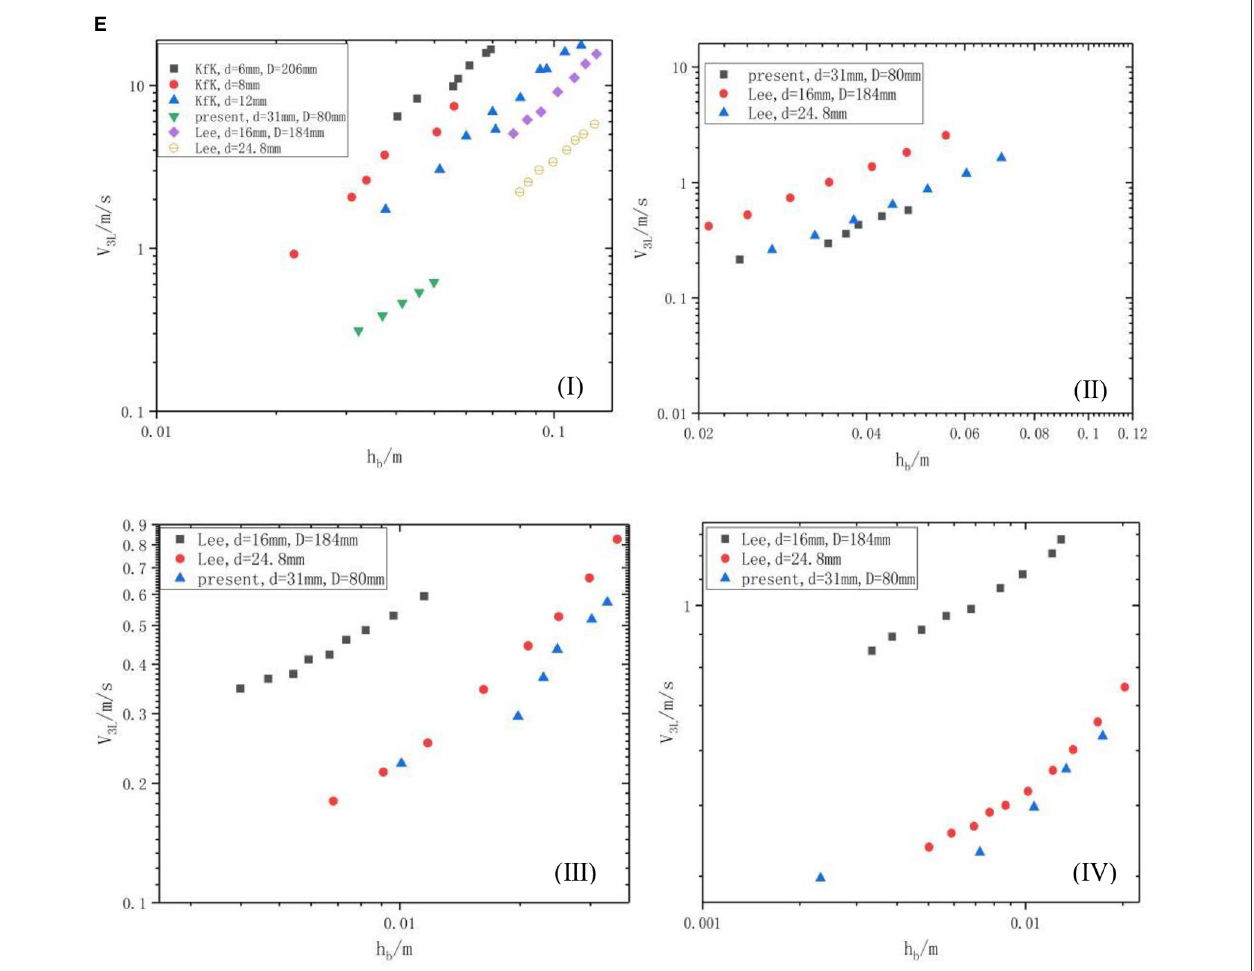
FIGURE 2 | The phenomenon and influencing factors of gas entrainment. (A) The OGE data at − 30 ◦ , − 45 ◦ , − 60 ◦ , − 90 ◦ branches. (B) Force diagram of bubbles. (C) Vortex position, (I) θ = − 90 ◦ , (II) θ = − 60 ◦ , (III) θ = − 45 ◦ , and (IV) θ = − 30 ◦ . (D) Onset phenomenon at arbitrary-sized branches, (I) d = 10mm ( Shen et al., 2018), (II) d = 31mm, and (III) d = 50mm (Shen et al., 2018). (E) Comparison of present OGE data with KfK and Lee, (I) θ = − 90 ◦ , (II) θ = − 60 ◦ , (III) θ = − 45 ◦ , and (IV) θ = − 30 ◦